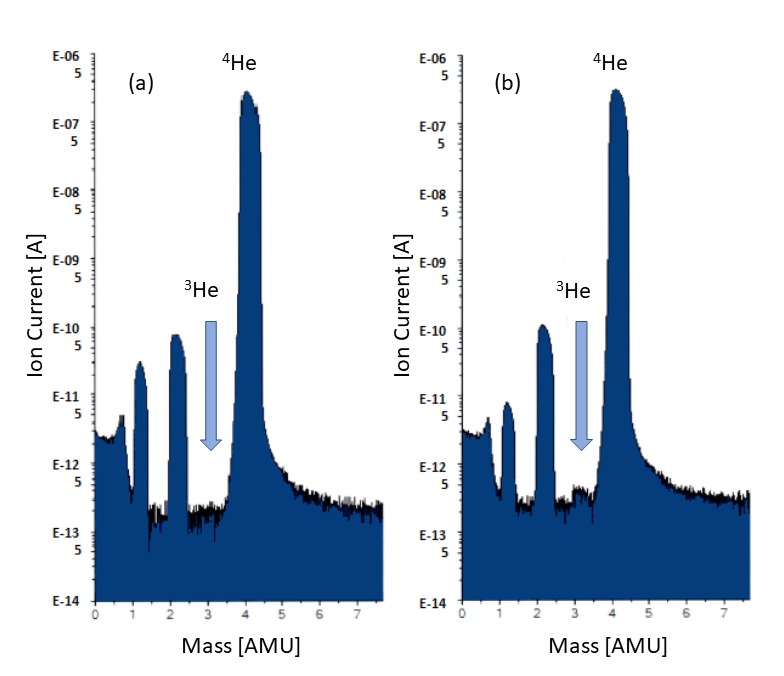
Figure 7. Results of two measurements of 3 He concentration: ( a ) beginning and ( b ) intermedi- ate